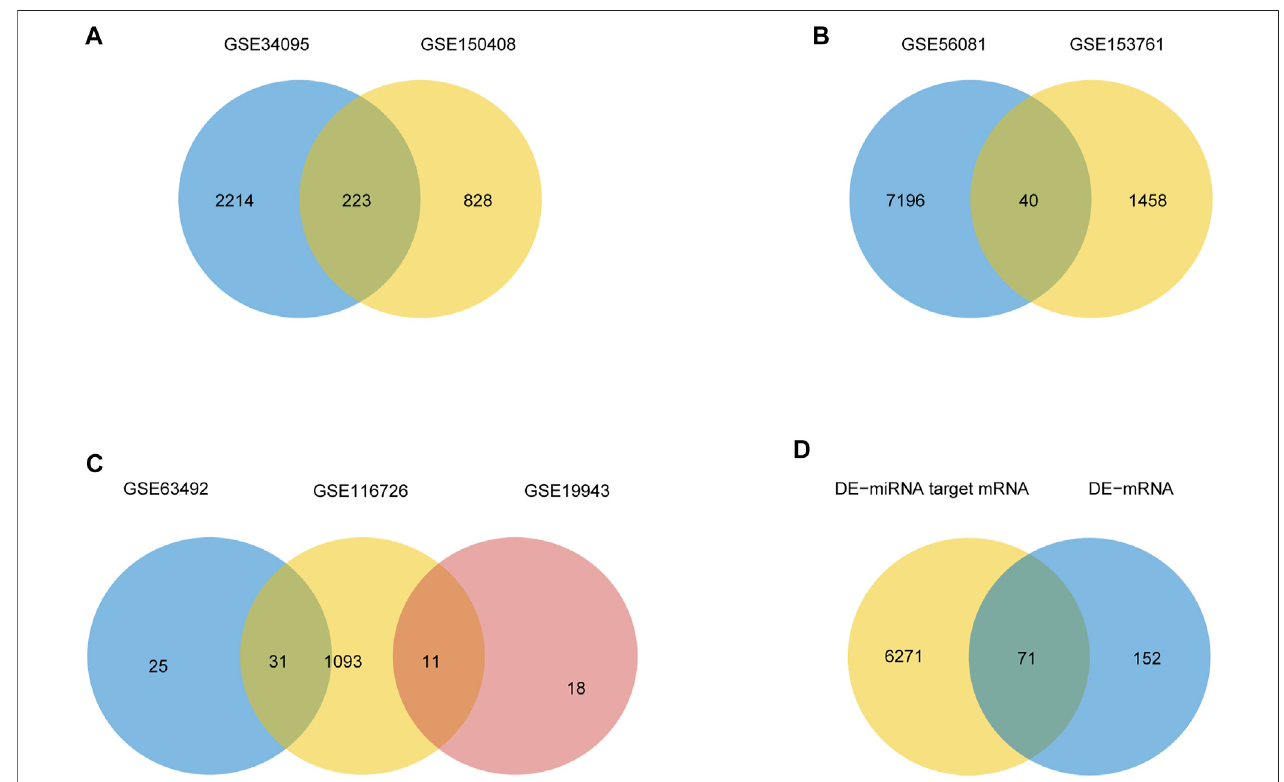
FIGURE 4 | Differential expression of mRNA, lncRNA, miRNA, and hub gene in IDD. (A) Venn diagram of differentially expressed genes in two sets of mRNA data. (B) Venn diagrams ofdifferentially expressed genes intwo sets oflncRNAdatasets. (C) Venn diagrams ofdifferentially expressed genesin three sets ofmiRNAdata. (D) IDD-related differentially expressed mRNA and miRNA-targeted mRNA Venn diagram.